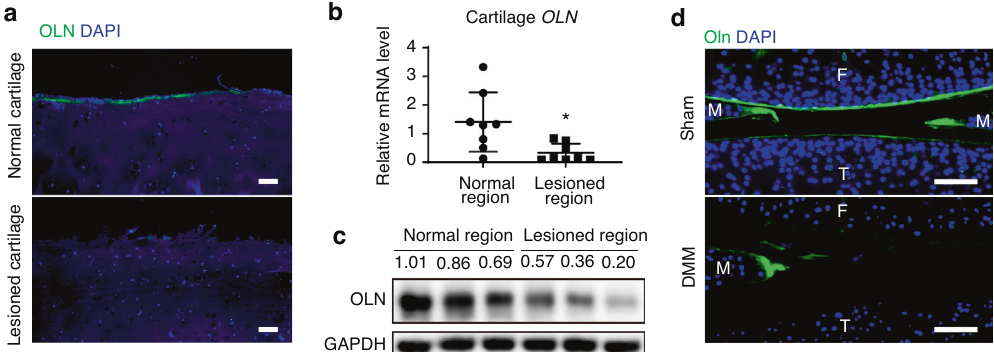
Fig. 6 Expression analysis of Oln in OA cartilage. a Immunostaining of human OLN in the articular cartilage of control and OA patients. DAPI staining indicates the nucleus. Scale bars: 100 μ m. b qPCR analysis of OLN mRNA levels in the articular cartilage of OA patients. Cartilage samples were separated into normal and lesioned regions based on their morphology ( n = 8 samples per group). c Western blot analysis of OLN protein levels in the articular cartilage from OA patients ( n = 3 samples per group). d Immunostaining of mouse Oln in the knee joints of sham and DMM-treated mice. Sham or DMM surgery was performed in 8-week-old wild-type mice, which were analyzed 8 weeks later (F: Femur; T: Tibia). DAPI staining indicates the nucleus. Scale bars: 100 μ m. The statistical signi fi cance was assessed using two-tailed Student ’ s unpaired t tests. Data are presented as the mean ± SD (* P < 0.05)